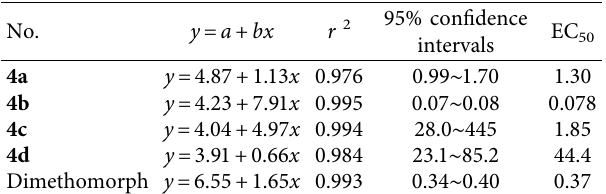
Table 1: The EC 50 of isolated four compounds against P. capsici ( μ